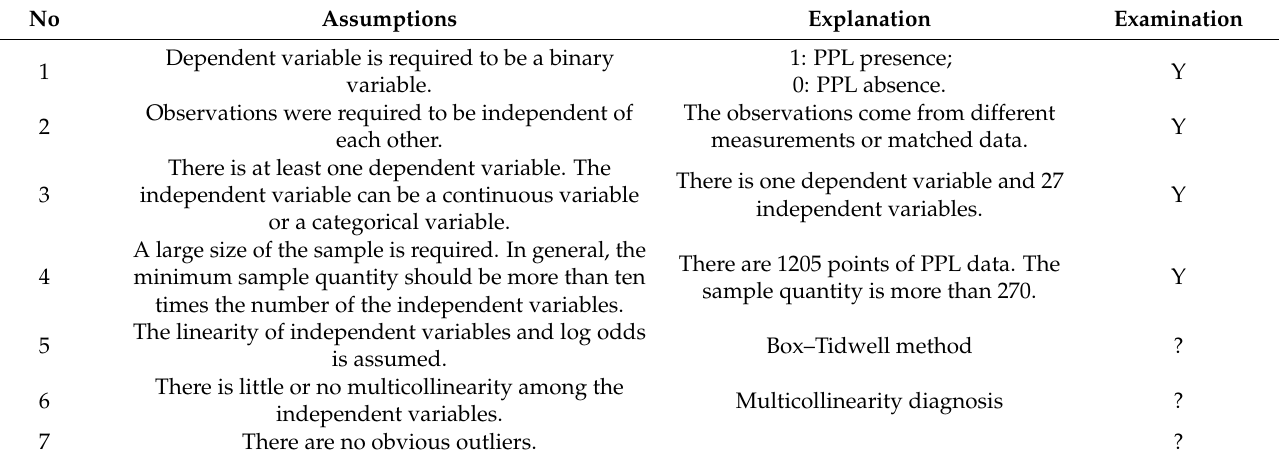
Table 4. Assumptions of the LR